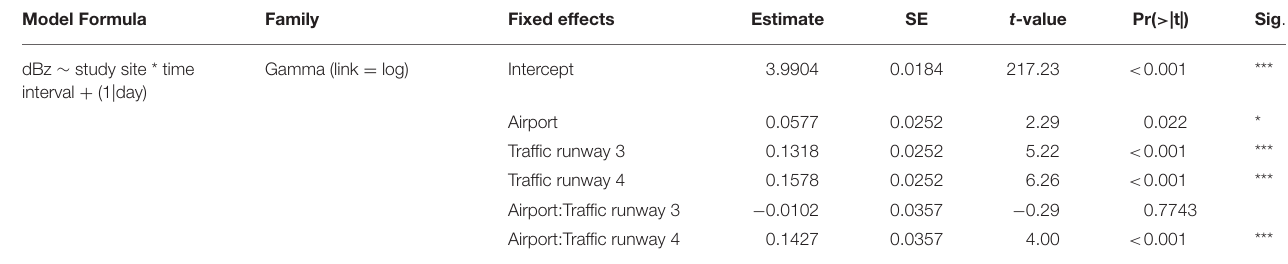
TABLE 1 | Results from the GLMMs to understand noise differences between